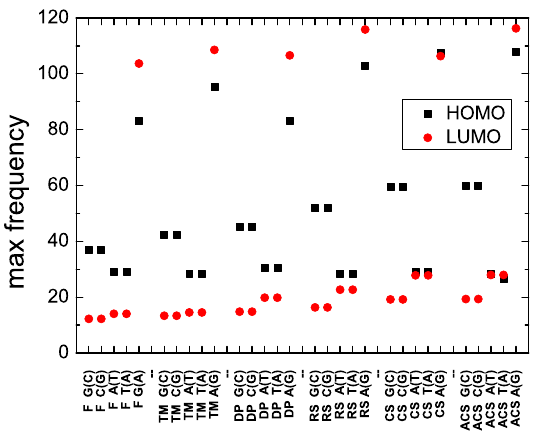
Figure 8. The maximum frequency of the Fourier spectrum, for the HOMO and the LUMO regime of Fibonacci, Thue–Morse, Double Period, Rudin–Shapiro, Cantor Set, Asymmetric Cantor Set polymers, at the large N limit. The notation of polymers is given in Table